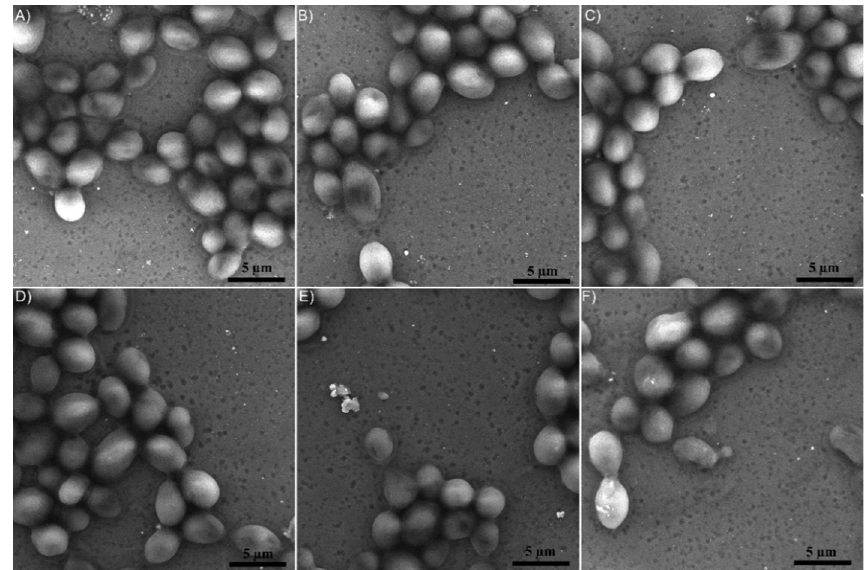
Figure 10. SEM images of C. albicans ATCC 10231 cell development on HAp coated Si discs used as the control ( A , D ), and the ZnHAp-500 and ZnHAp-700 layers after 24 h ( B , C ) and 48 h ( E , F ) of incubation.